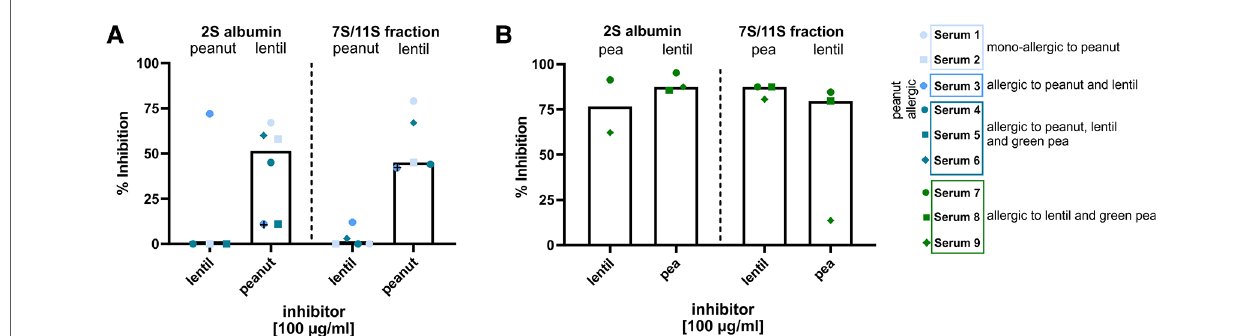
FIGURE 4 Inhibition of IgE binding to peanut, green pea and lentil 2S albumin and 7S/11S fractions at an inhibitor concentration of 100 µg/ml. ( A ) Cross-inhibition of IgE binding to the 2S albumin and 7S/11S fractions from peanut and lentil in peanut-allergic subjects. ( B ) Cross-inhibition of IgE binding to the 2S albumin and 7S/11S fractions from green pea and lentil in green pea and lentil-allergic